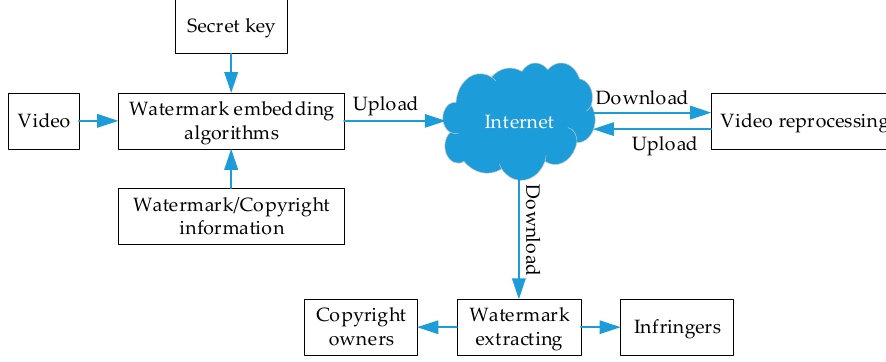
Figure 2. The application of video watermark in copyright protection.